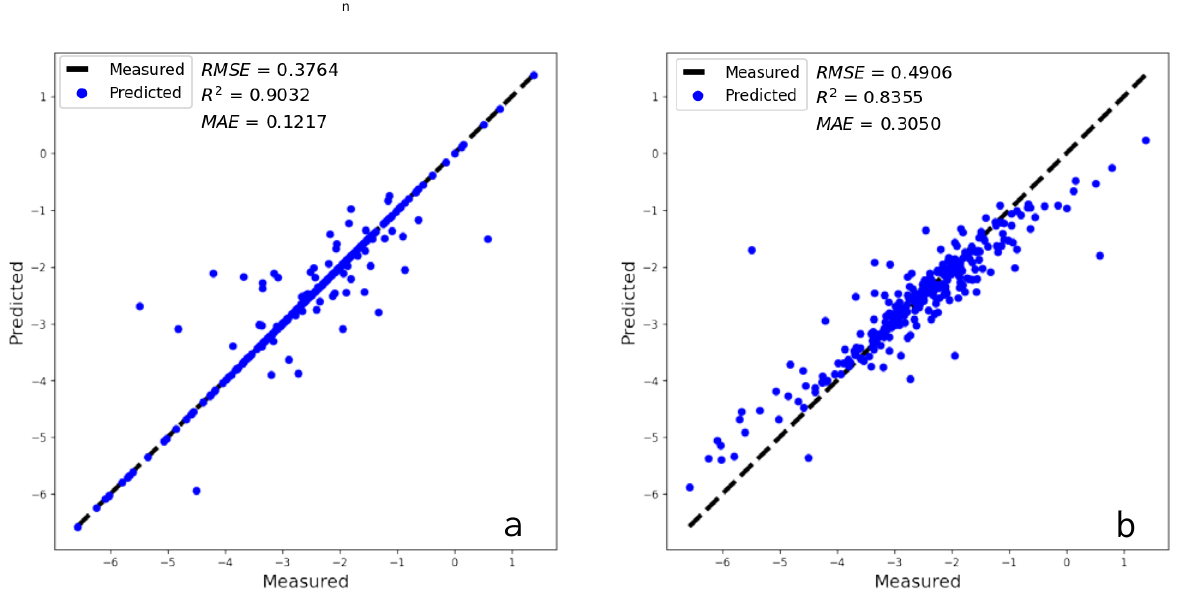
a Figure 6. Compatibility between the measured data and the predicted data (a) XGBoost, (b) RF.